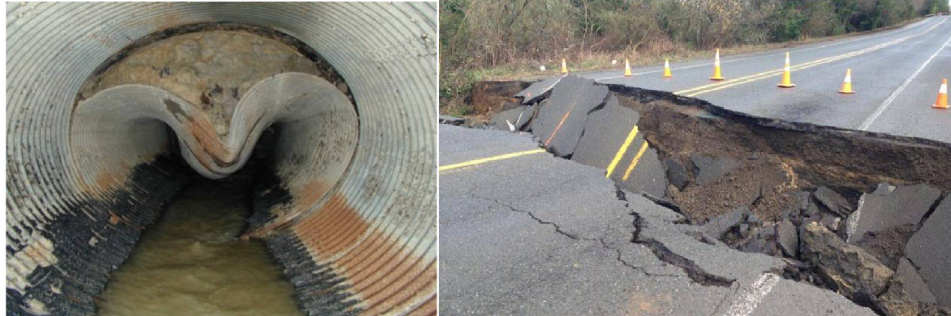
Figure 1. Left: culvert collapse on I-480 in Cleveland (USA) in 2001 [11]. Right: collapse of a culvert in Oregon (USA) in 2016 [12].